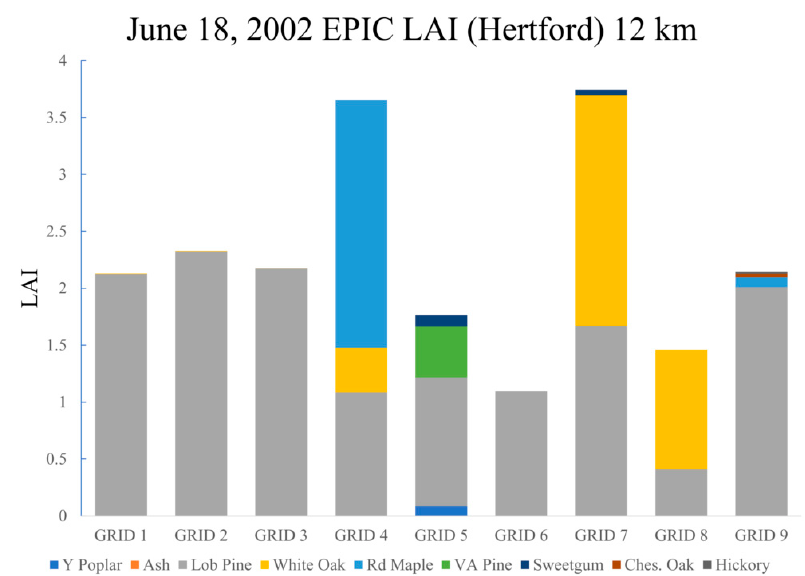
Figure A1. EPIC LAI for nine 12.0 km grid cells surrounding the Hertford site (18 June 2002). Bar colors represent nine tree species types and their proportion per grid cell.